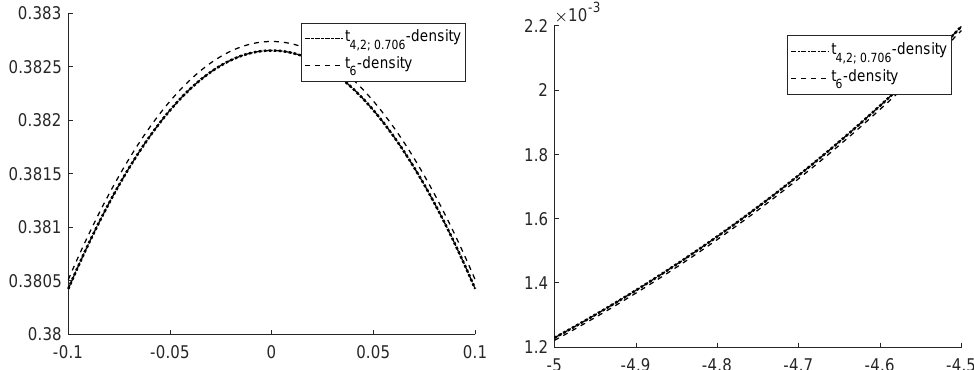
Figure 5. Densities of t 4,2; 0.706 and t 6 around the origin and in the distribution